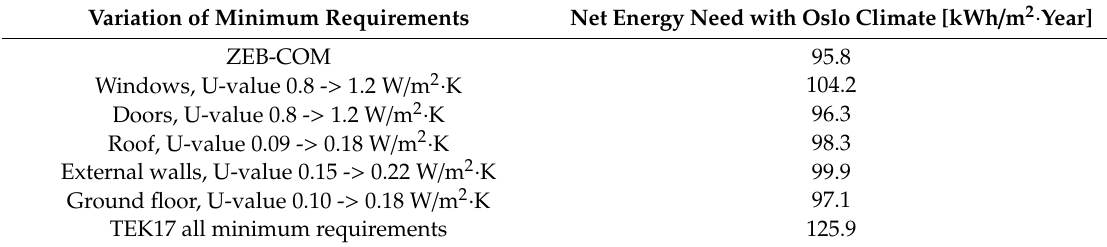
Table 4. Variation of the U-values of the building components from the ZEB-COM design values.